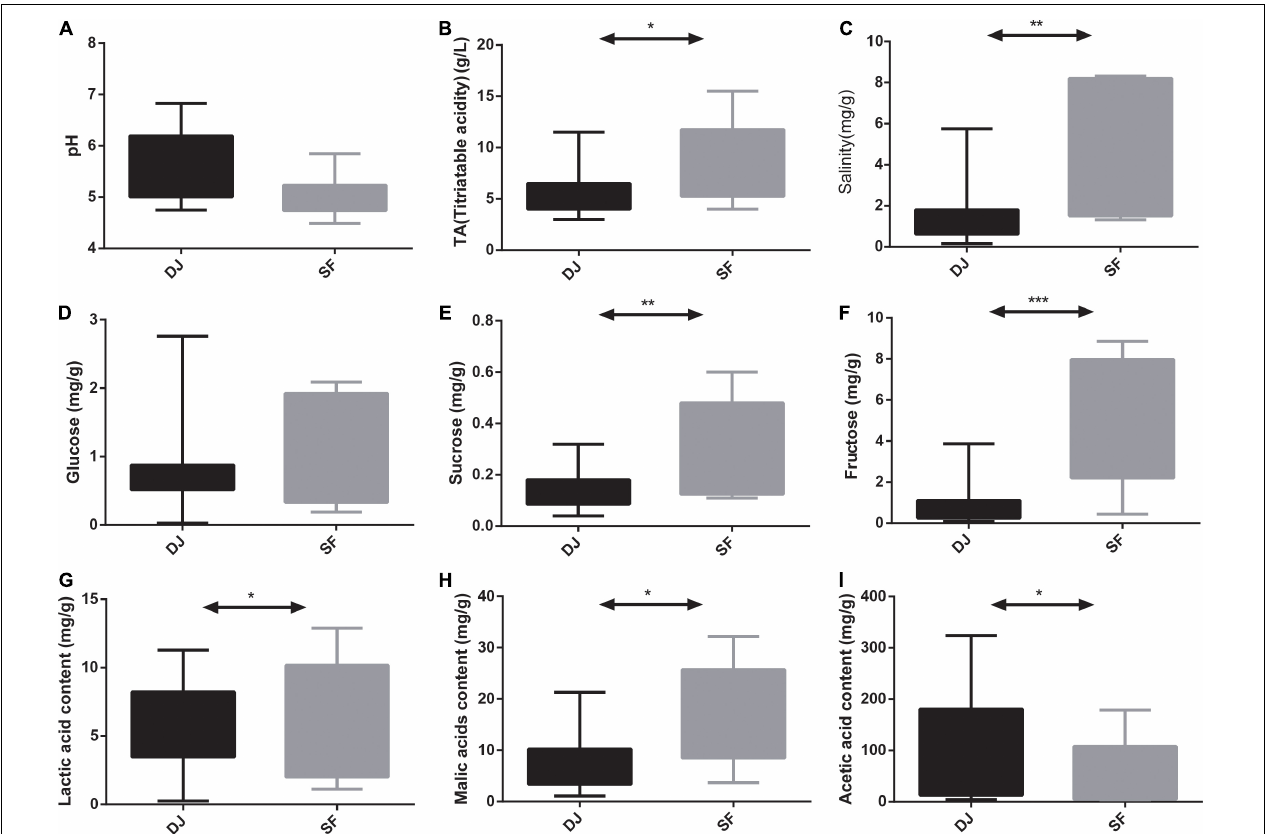
FIGURE 1 | Comparison of physicochemical properties between Dajiang and Sufu. (A) pH; (B) titratable acidity (TA); (C) salinity; (D) glucose; (E) sucrose; (F) fructose; (G) lactic acid; (H) malic acid; (I) acetic acid. Statistical significance between groups was determined using t -tests. * P < 0.05, ** P < 0.01, *** P < 0.001.